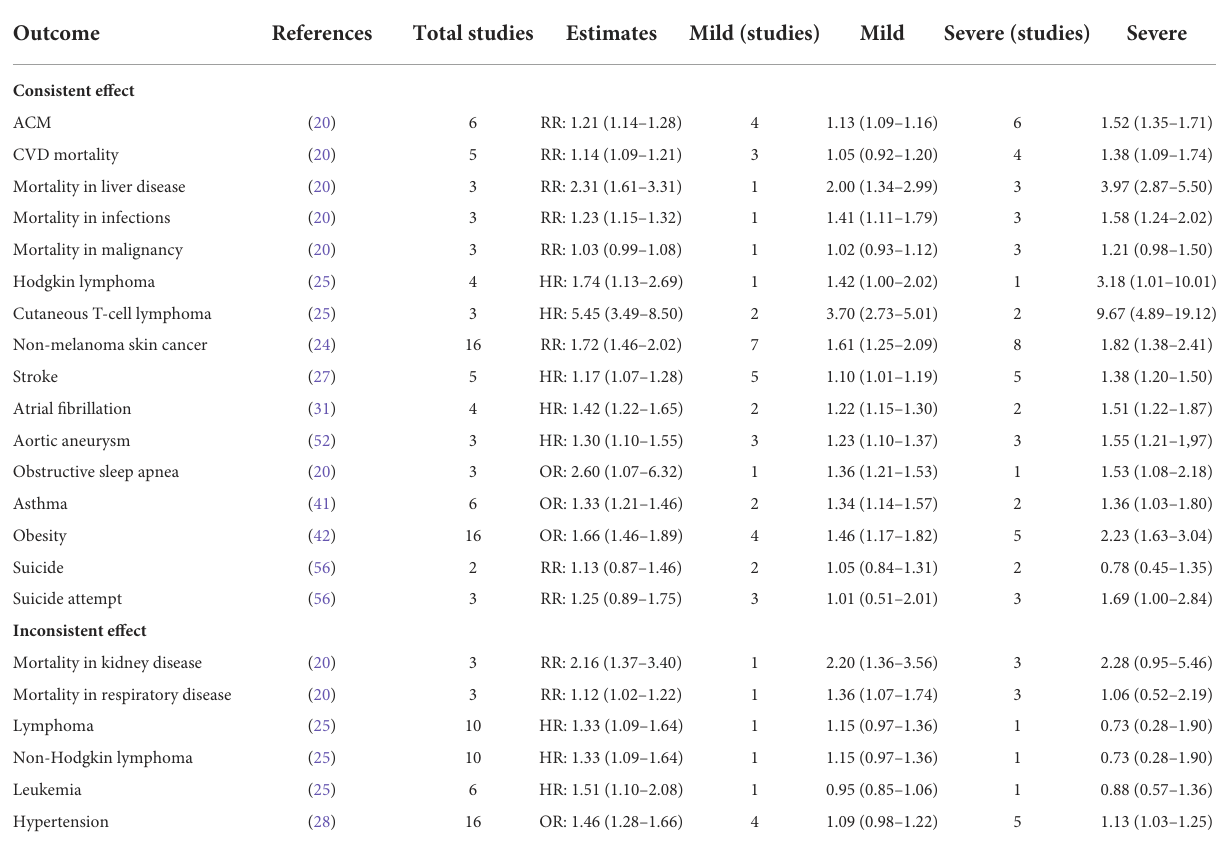
TABLE 1 Subgroup analysis results by severity of